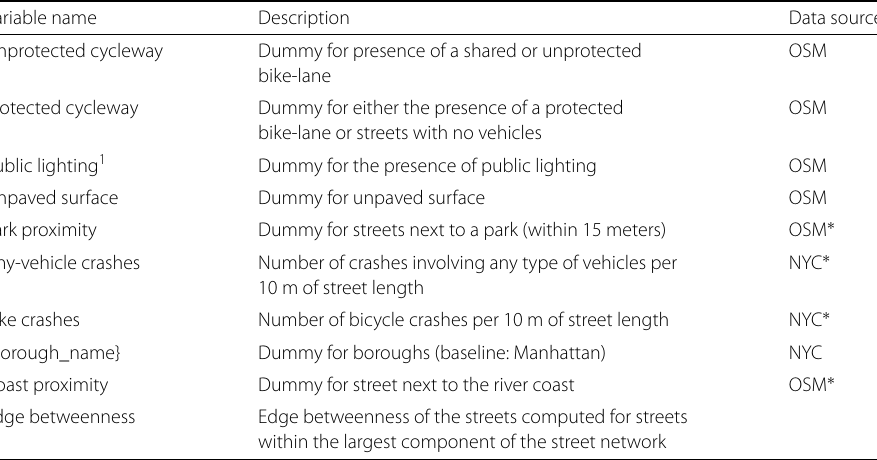
Table 2 Street-level indicators for the city of New York: description and